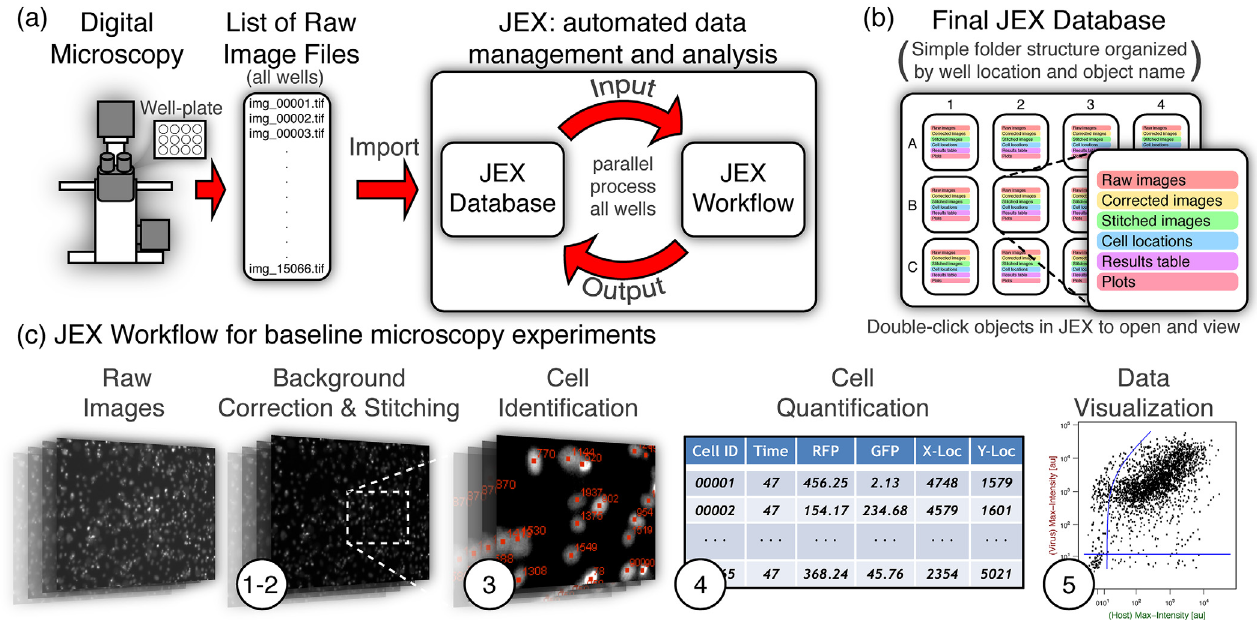
Fig 5. Data acquisition and analysis. a) Images are acquired in multiple colors and locations over time. The resultant list of files is imported into JEX. JEX performs analysis on the imported data, and stores the outputs into the same database. All function parameters and data from intermediate steps can be recorded in the JEX database. b) The database of information is stored in a simply named and transparent folder structure for perusal and use outside of JEX, but is also easily accessed via the JEX user interface. c) The workflow for baseline microscopy experiments generally consists of: 1) an initial background and illumination correction, 2) stitching the image array for each color and timepoint within each well, 3) identification of cells based on Hoechst staining, 4) quantification of cell location and fluorescence intensity for each color, and 5) plotting of results. The workflow for MA-based experiments includes additional functions for identifying microwells, counting the number of cells within each microwell, and quantifying whole-microwell and single-cell fluorescence. See S1 Text for details of all